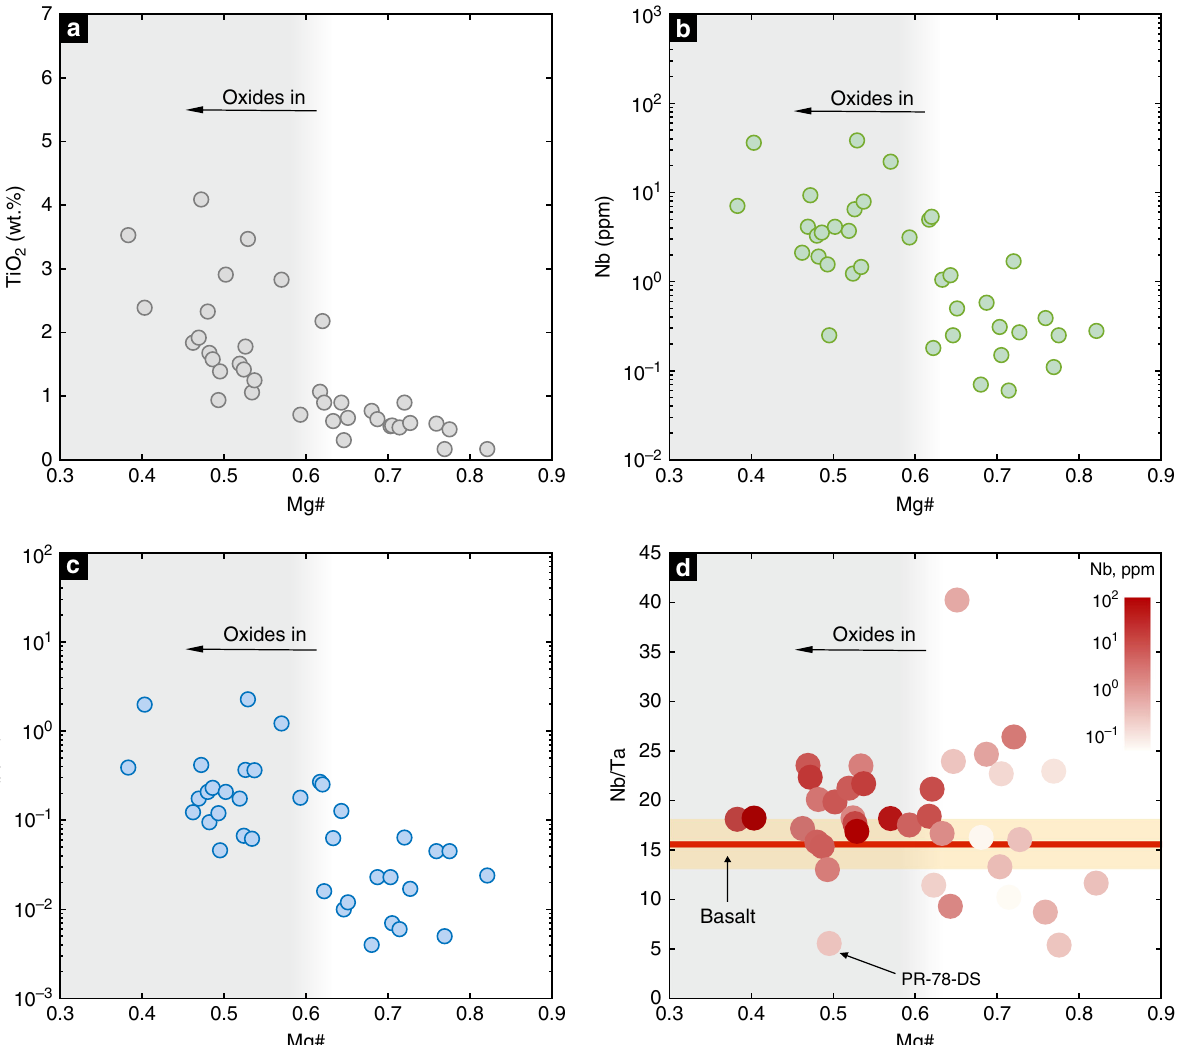
Fig. 2 Arclogite TiO 2 , Nb, and Ta concentrations, and Nb/Ta ratio vs. Mg#. The dots in d are color-coded by whole rock Nb concentrations. The gray shaded areas indicate the presence of rutile and Fe – Ti oxides in the samples. The red line in d shows the average Nb/Ta ratio of global arc basalts and the orange band shows the one standard deviation (1 σ )